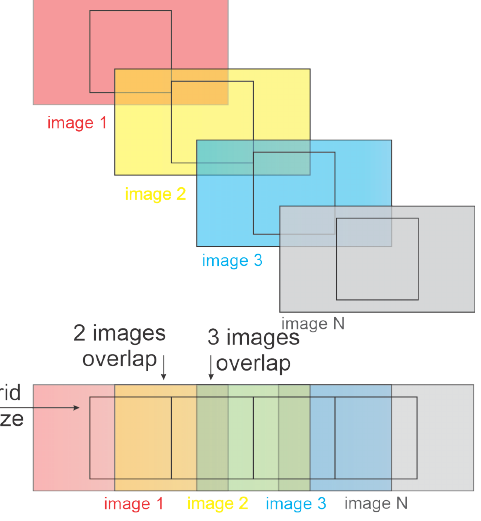
Figure 3. Image overlap representation.